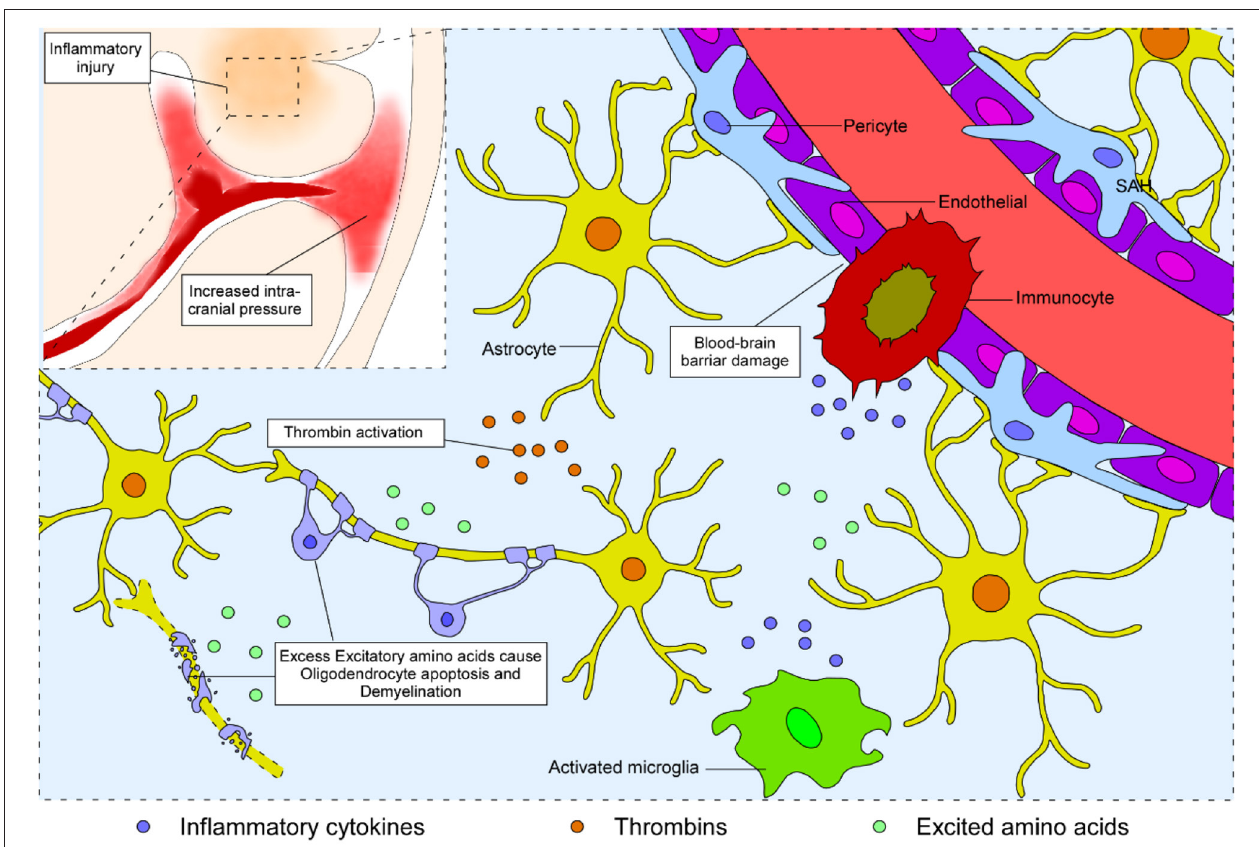
FIGURE 1 | Schematic representation of the process of white matter injury in the brain after SAH. Blood from the ruptured vessel enters the subarachnoid space and increases the intracranial pressure. Subsequently, biochemical factors, including thrombin, excitatory amino acids, and inflammatory cytokines, lead to disruption of the blood–brain barrier, neural apoptosis, and demyelination, eventually causing white matter injury after